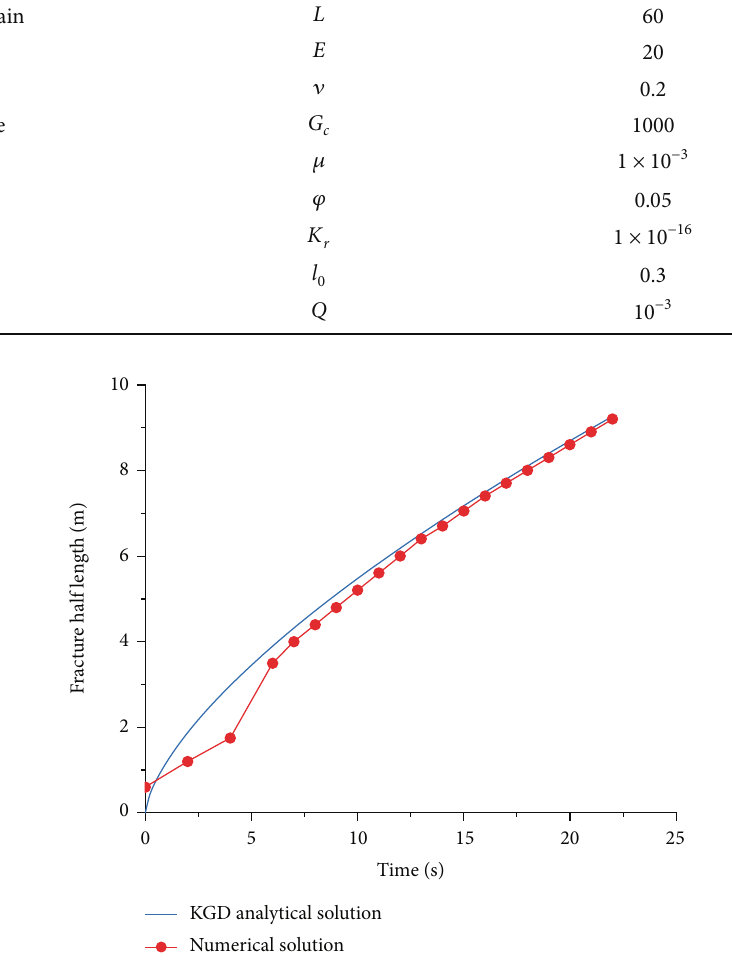
Figure 4: Comparison of numerical and analytical solutions. Table 2: Input parameters for validating fracture